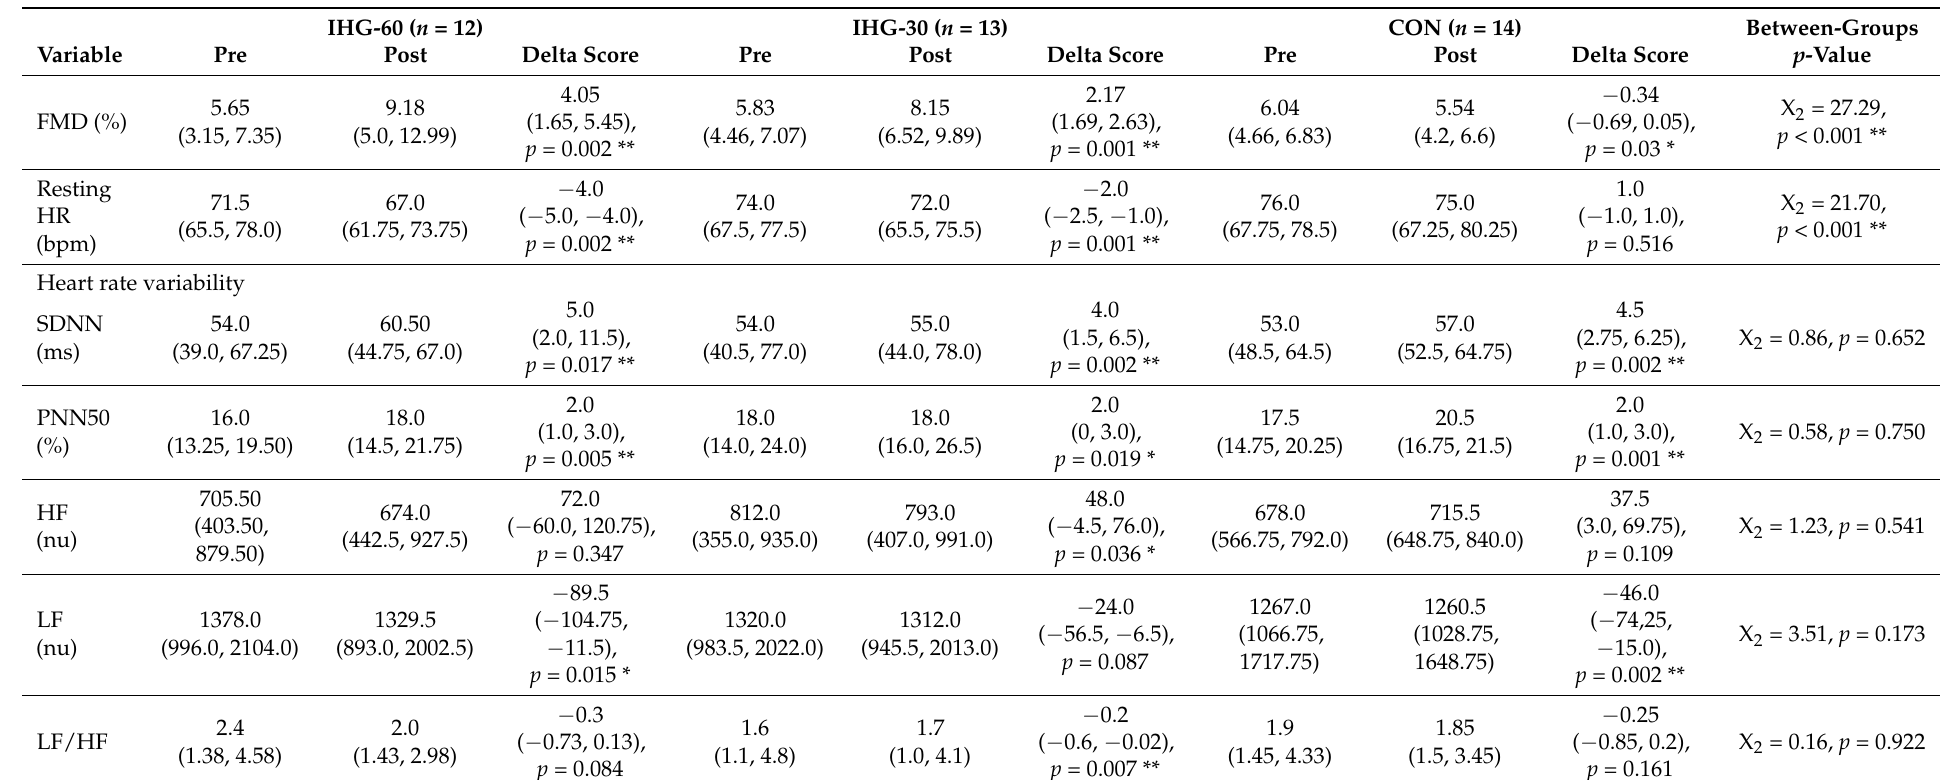
Table 1. Changes in cardiovascular outcomes within- and between